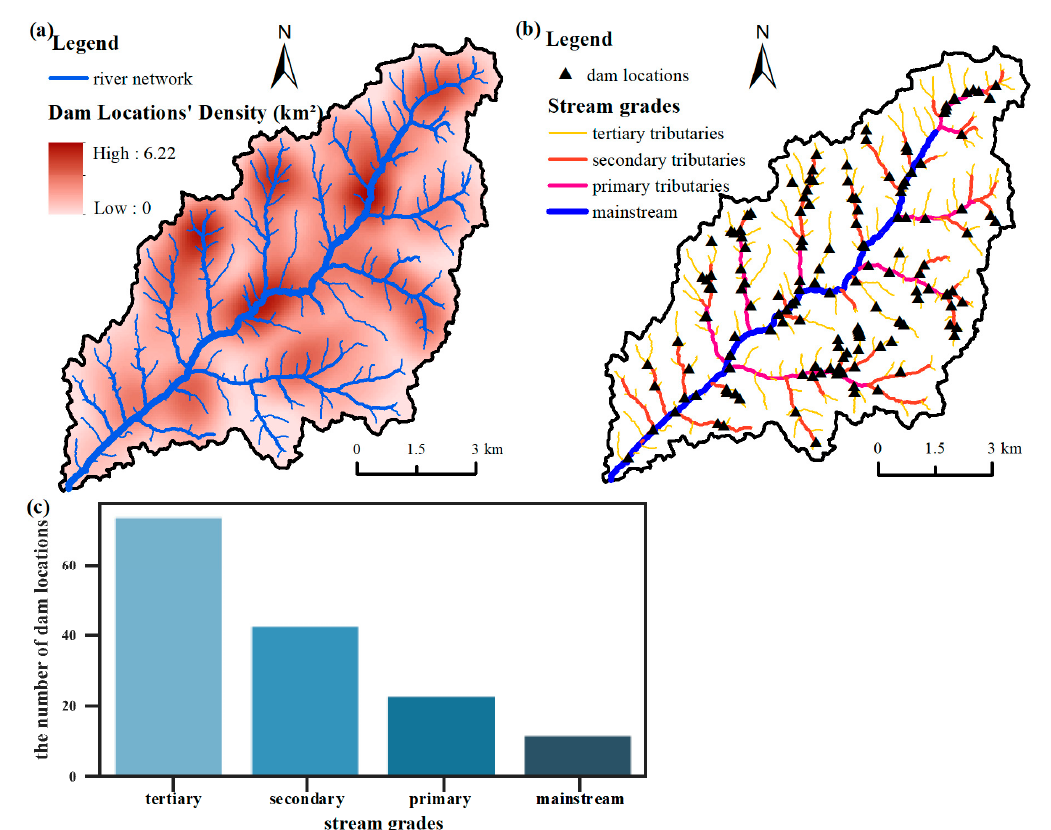
Figure 11. Spatial distribution of check dam systems: ( a ) dam location density; ( b ) distribution of check dams in different stream grades; ( c ) histogram of check dams in different stream grades.